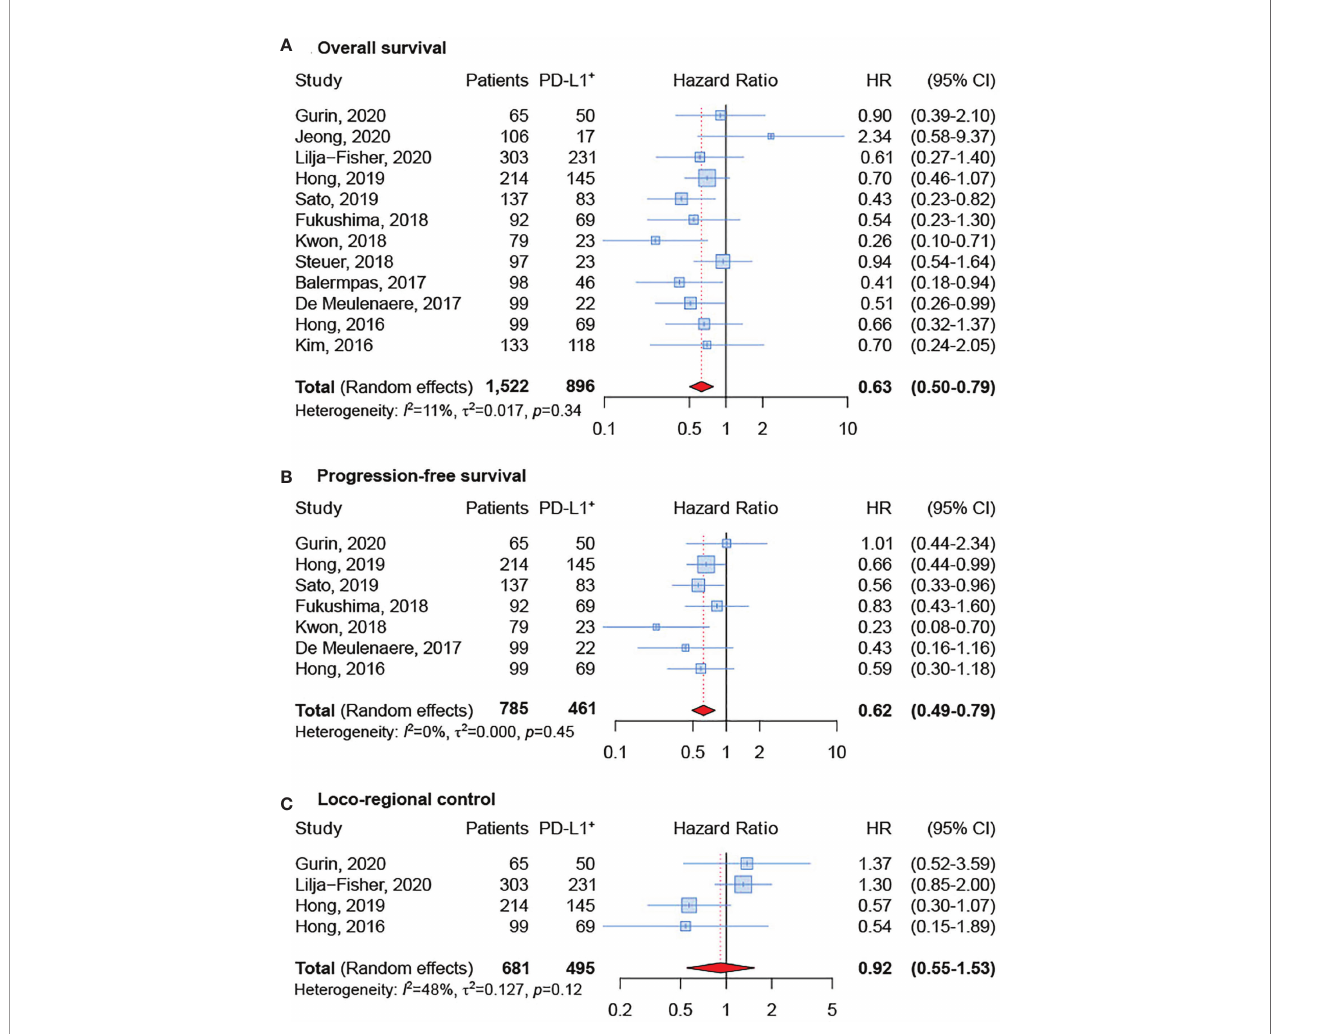
FIGURE 2 | Forest plot for the association between PD-L1 expression and overall survival (A) , progression-free survival (B) , and loco-regional control (C)